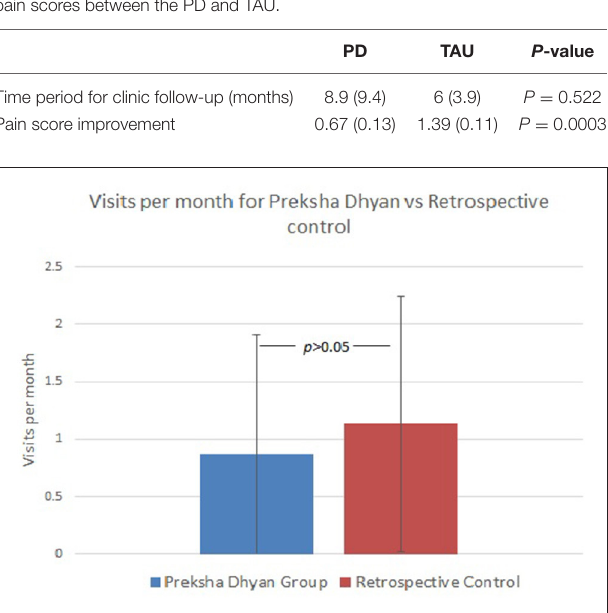
completion rates (mean 4.3 weeks or 2.15 visits) with continued in-home daily sessions using guided handouts.